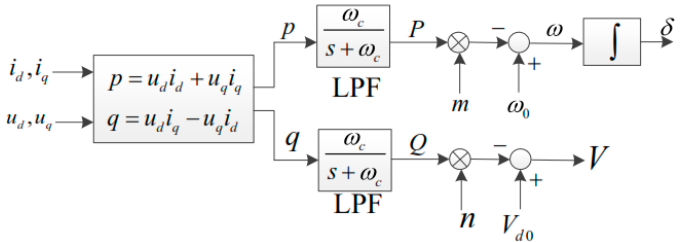
Figure 3. Control diagram of the traditional droop.